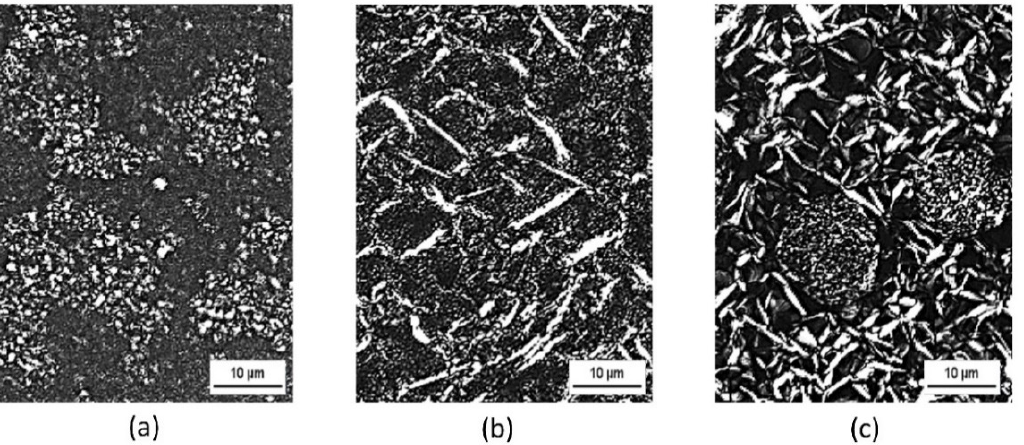
Figure 2. Polarized micrograph of ( a ) SL/PO, ( b ) GMS/PO, and ( c ) SL/GMS/PO organogel under high magnification (40 × ).